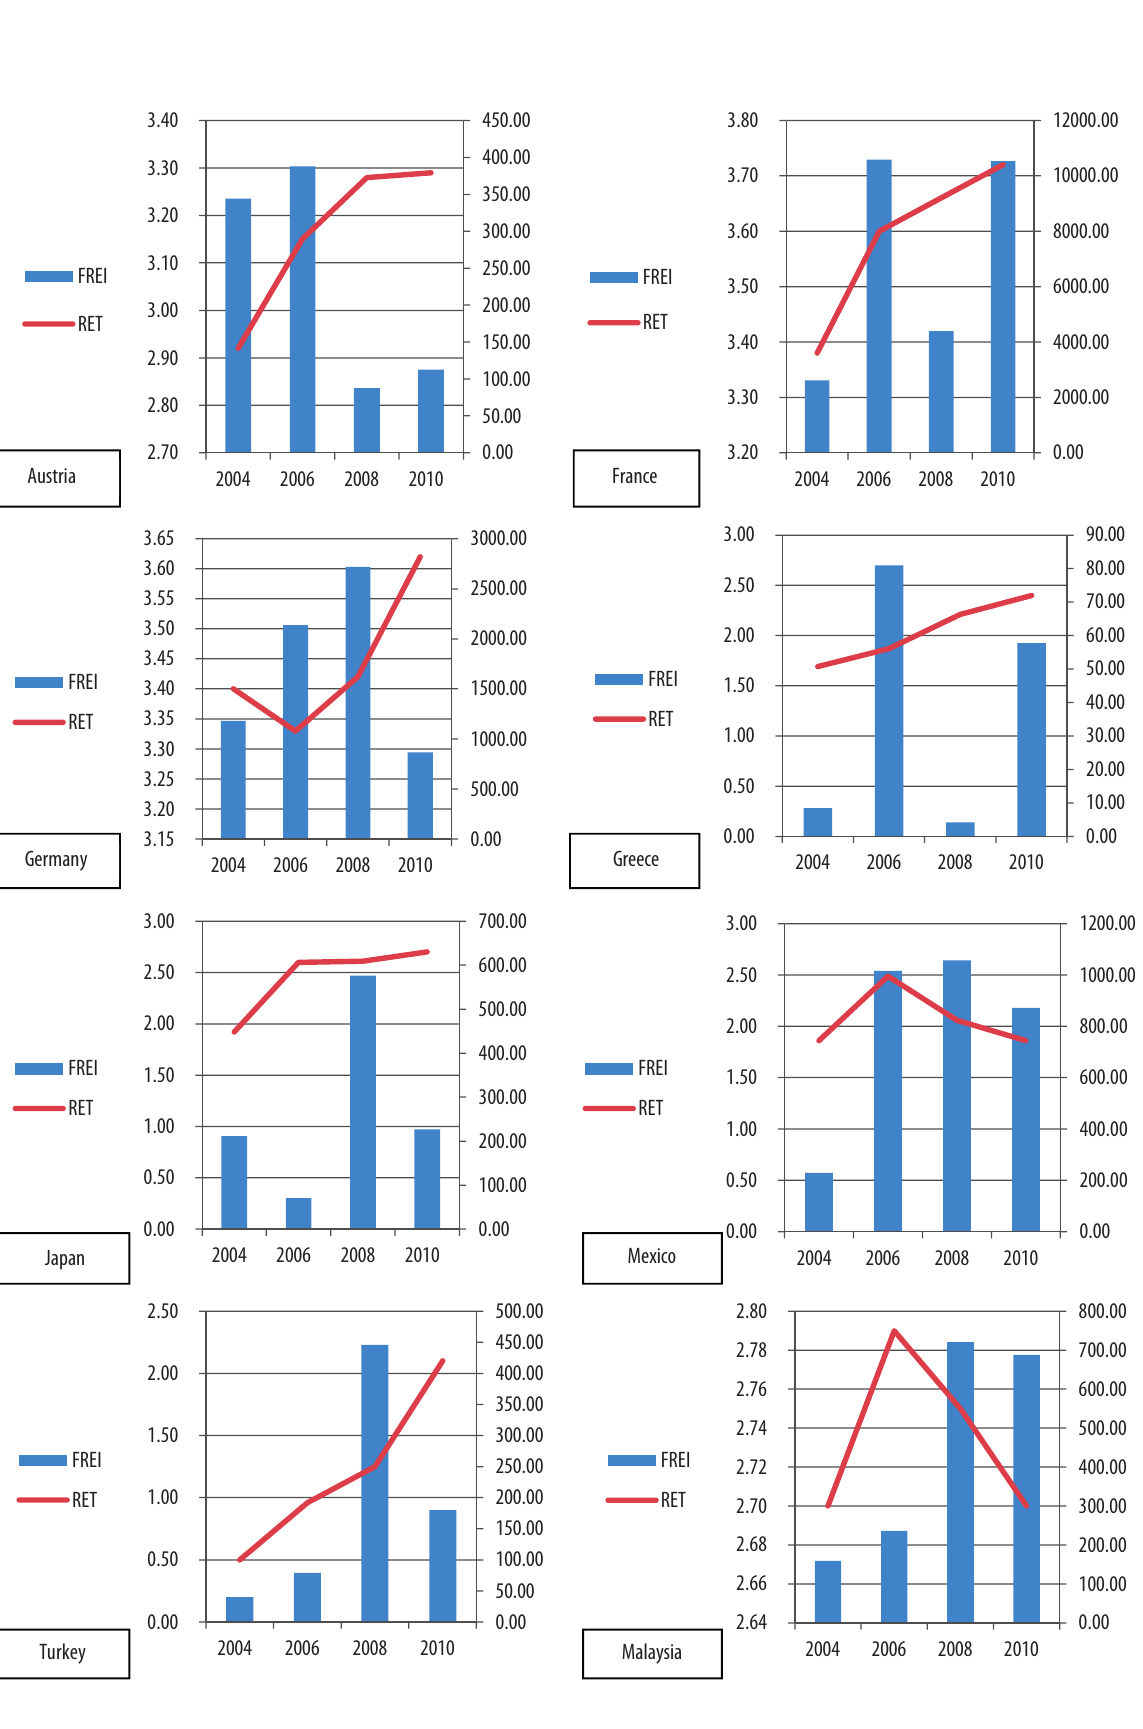
Fig. 2. The association between real estate transparency ( RET ) and foreign investments in real estate ( FREI